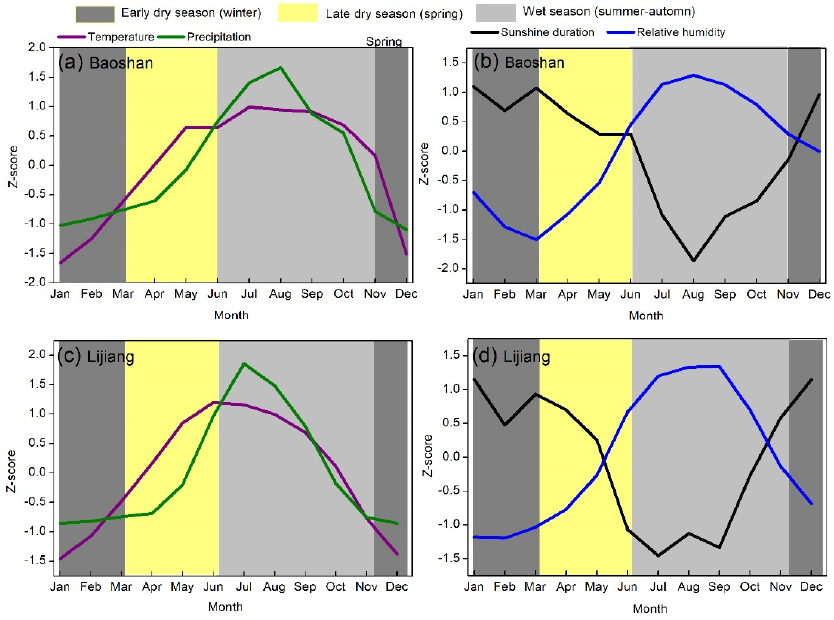
Figure 2. Variations of monthly mean air temperature and precipitation ( a and c ), and relative humidity and sunshine duration ( b and d ) recorded at Longya and Lijiang Meteorological Stations between 1951 and 2019 in Yunnan, southwest China. All the data were standardized using Z-scores.